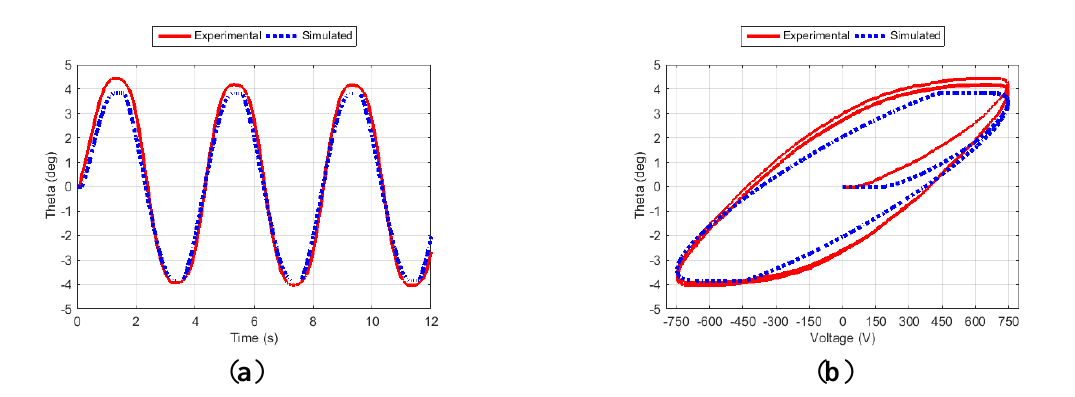
Figure 9. Fin angle ( a ) and hysteresis curve ( b ) for Case 7.